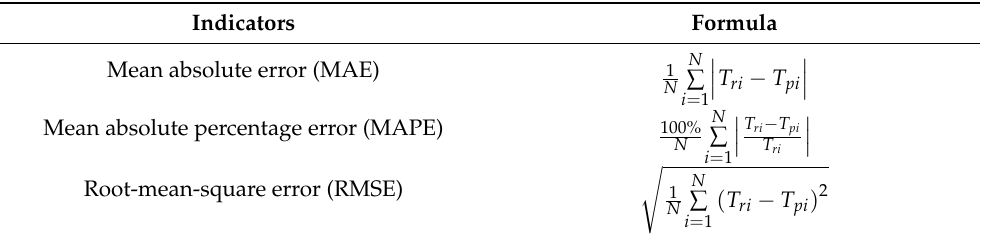
Table 5. Evaluation